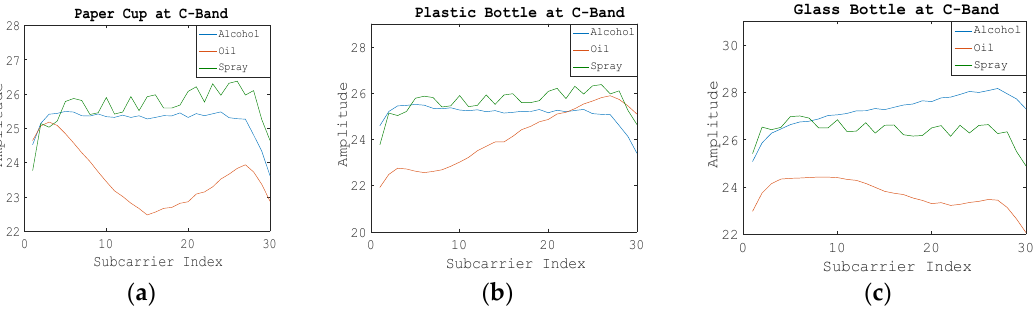
Figure 7. Amplitude information of 30 subcarriers of Step 2 at the C-band. ( a ) Using the paper cup; ( b ) Using the plastic bottle; ( c ) Using the glass bottle.